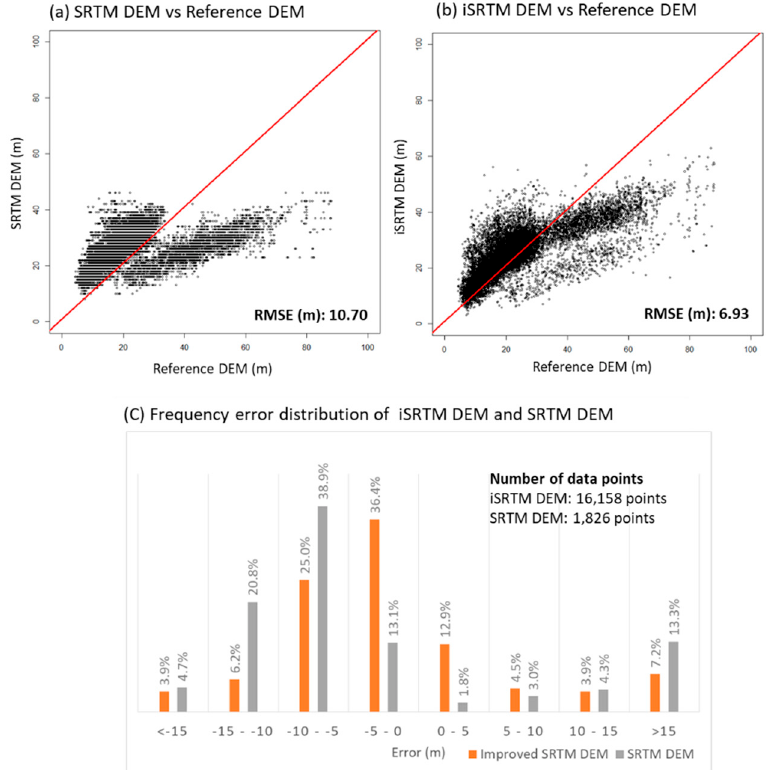
Figure 8. Scatter plots and root mean square error (RMSE) comparisons between ( a ) SRTM DEM and ( b ) iSRTM DEM; ( c ) frequency error distribution comparisons in dense urban area in Singapore.